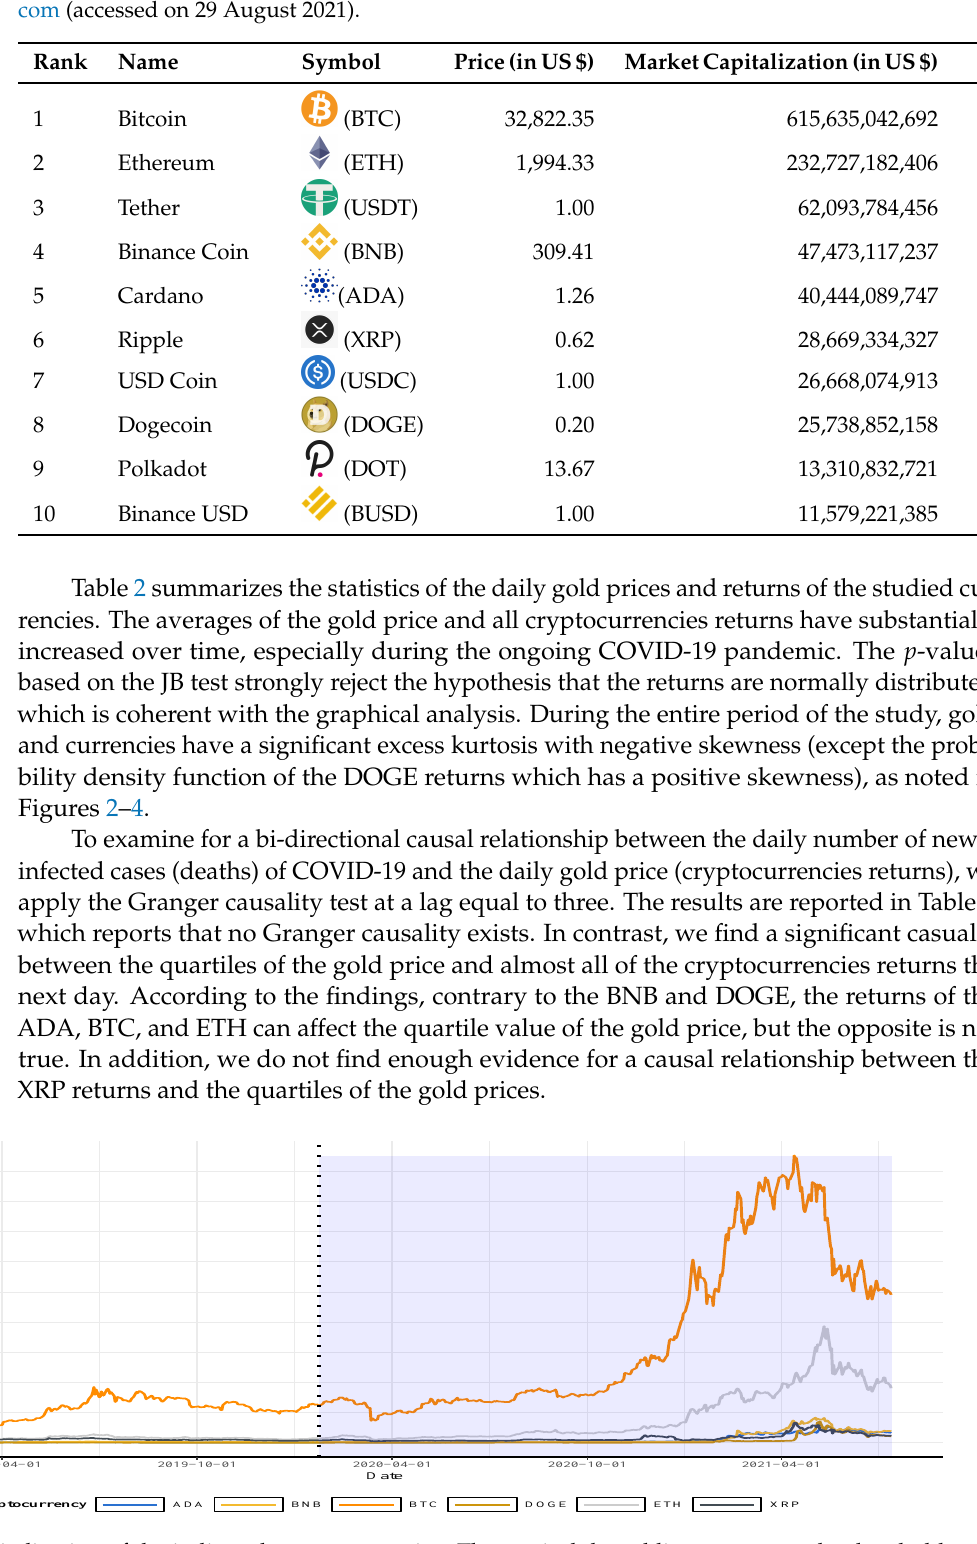
Table 1. Characteristics of the top ten cryptocurrencies (14 July 2021). Source: https://coinmarketcap.